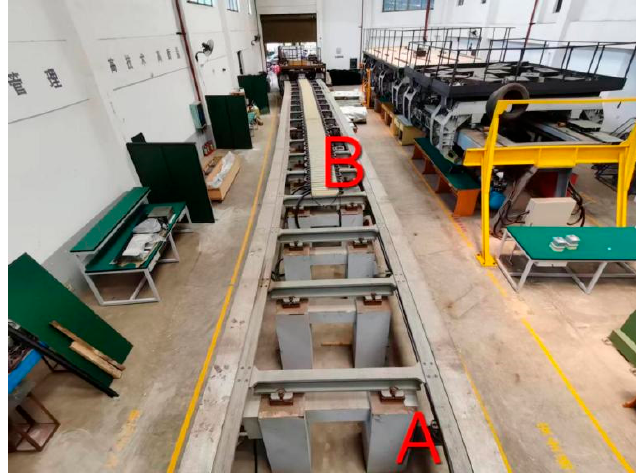
Figure 20. Curved rail of physical experiment platform.